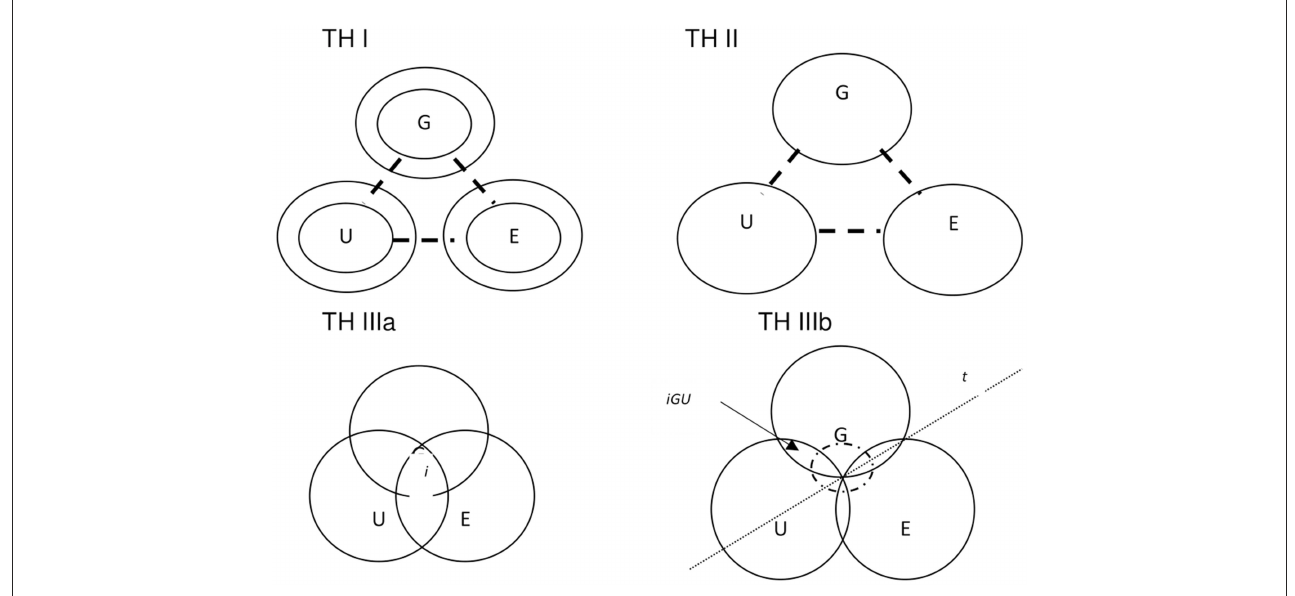
FIGURE1 Evolution of triple helix model (TH I, TH II, TH III). Source: Our elaboration by Etzkowitz (2008) and Leydesdorff (2008). G, government; E, enterprise; U, university; i, common ground; t, time line.